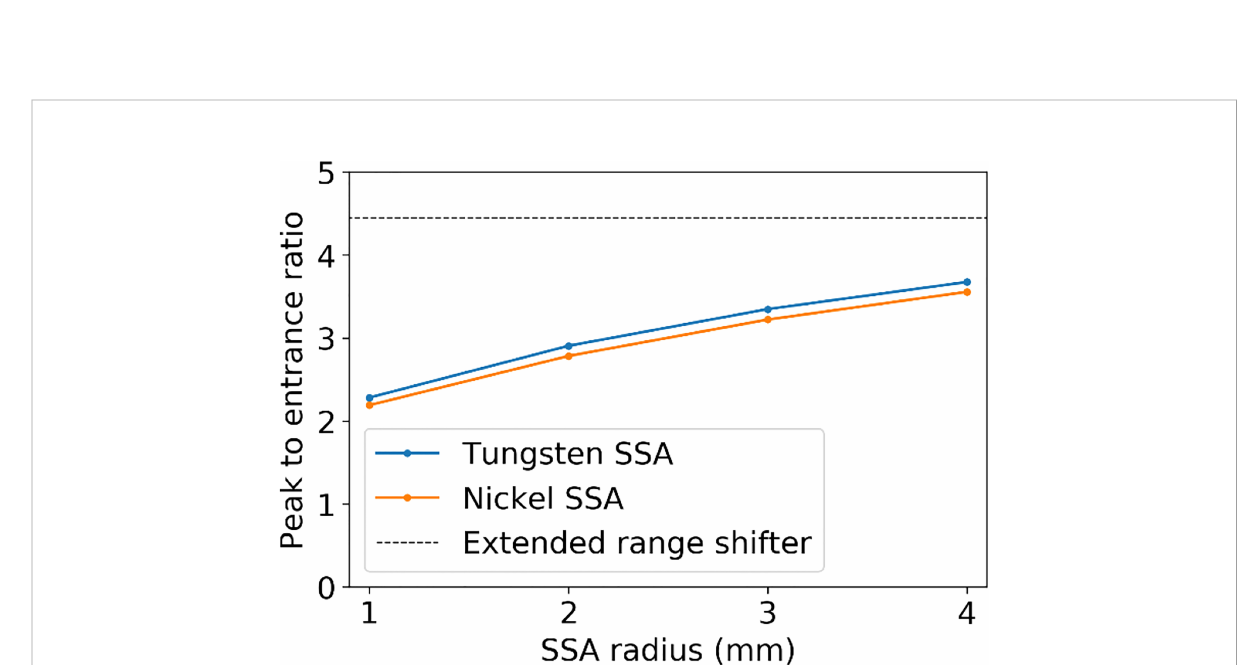
FIGURE 7 The peak to entrance dose ratio for the SSA with aperture opening radii varying from 1 to 4 mm and an ASD of 50